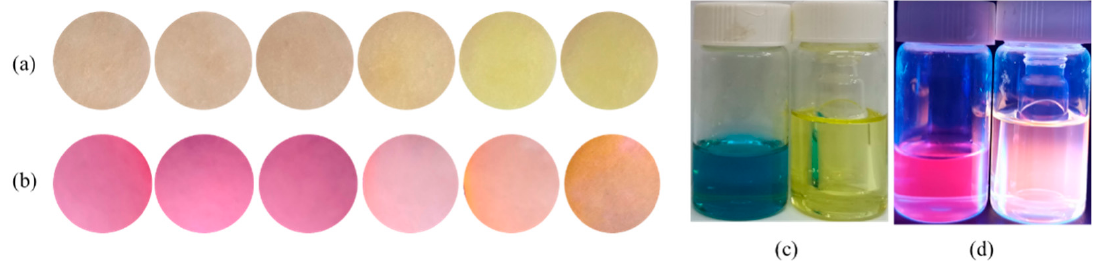
Figure 5. The color changes in the paper sensors at different concentrations of DCP ( a ) under visible light and ( b ) under ultraviolet light. From left to right: [DCP] = 0, 1.0 × 10 − 5 M, 1.0 × 10 − 4 M, 1.0 × 10 − 3 M, 1.0 × 10 − 2 M, 1.0 × 10 − 1 M. The color changes in SWJT-20 (10.0 µM) dissolved in DMF and